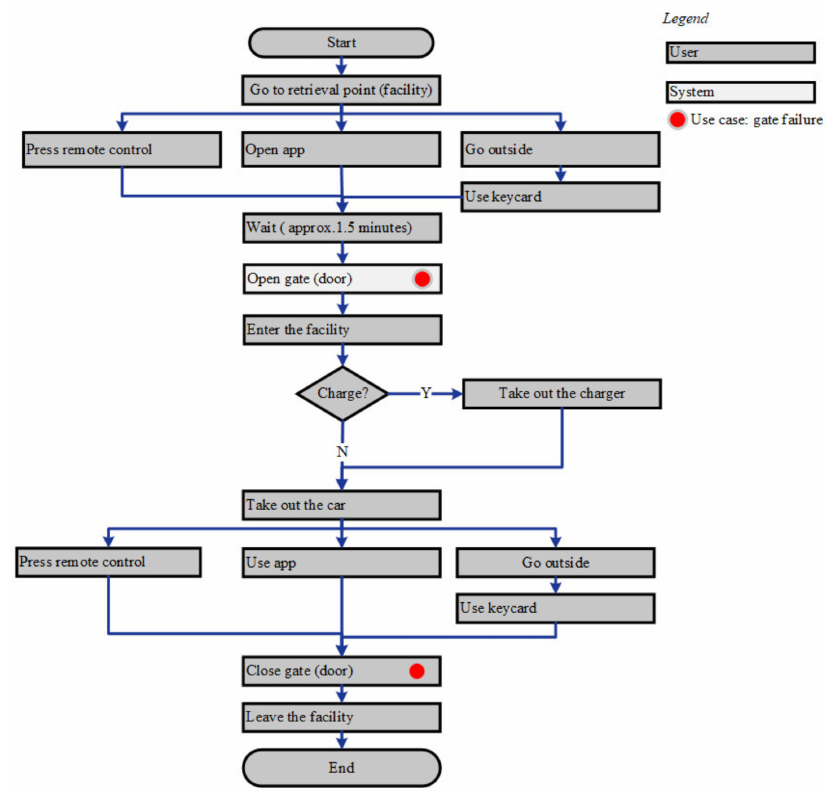
Figure 24. Workflow for car retrieval from the